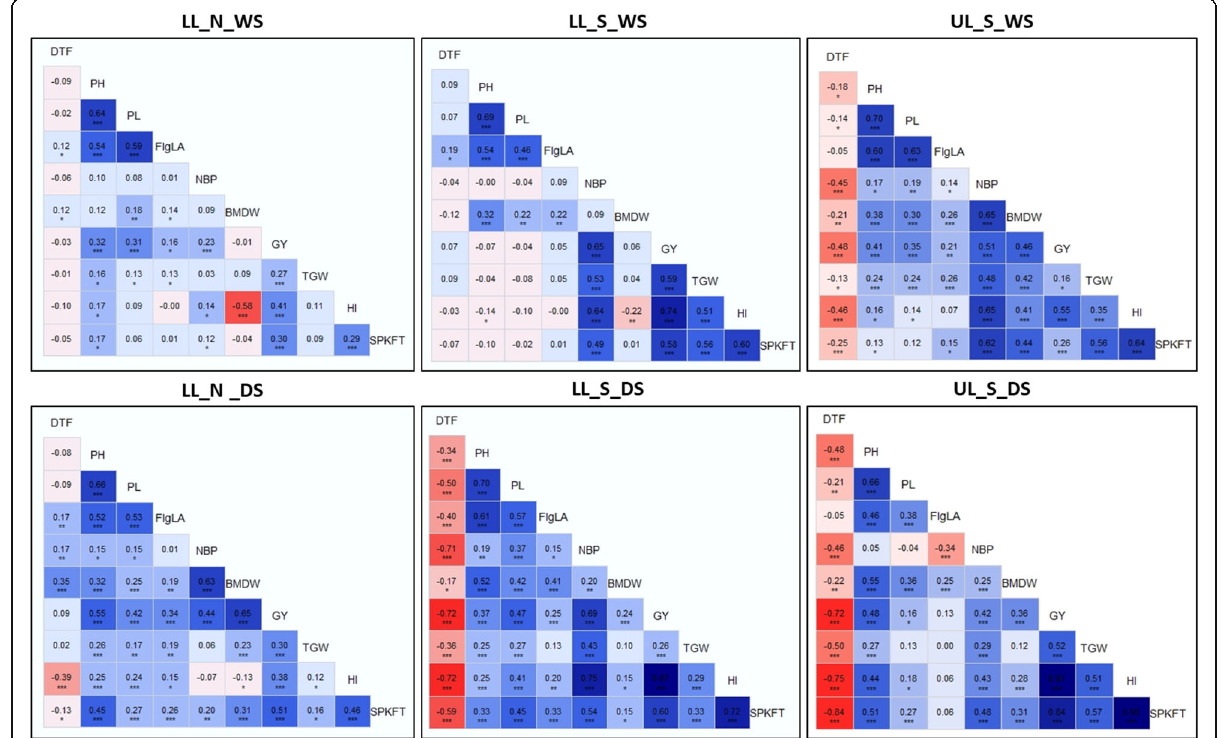
Fig. 2 Plots of Pearson ’ s r- values showing correlation between each of the ten traits in each of the six experiments (LL_N_WS-lowland non-stress 2014WS, LL_N_DS-lowland non-stress 2015DS, LL_S_WS-lowland stress 2014WS, LL_S_DS-lowland stress 2015DS, UL_S_WS-upland stress 2014WS and UL_S_DS-upland stress 2015DS). Blue color indicates positive correlation and red color indicates negative correlation among different traits, with color intensity variance depicting the strength of correlation. *significant at < 0.05 level, **significant at <0.01 level, *** significant at < 0.001 level, blank for